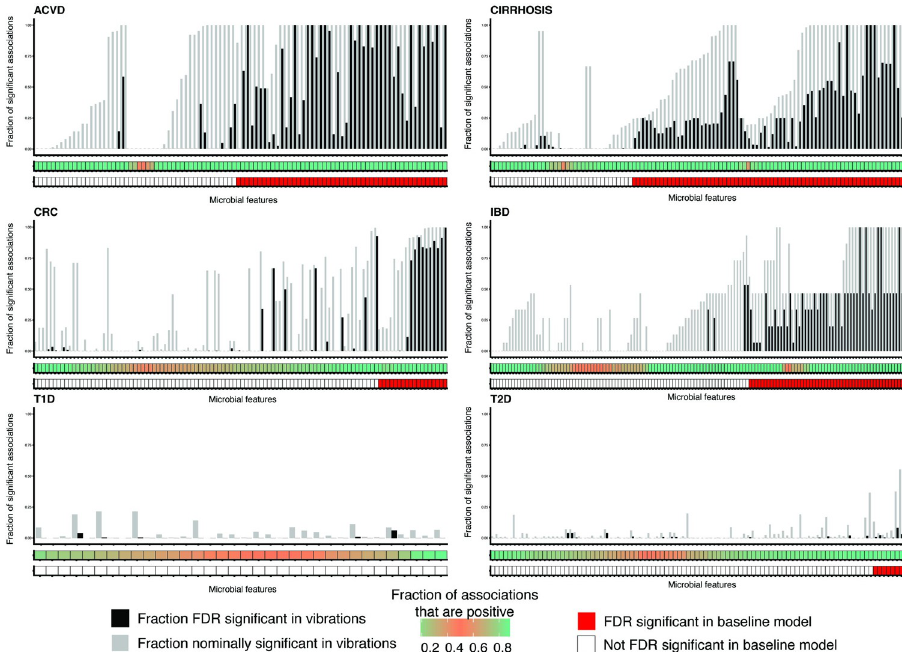
Fig 3. VoE for reported associations from the literature in the form of summarized modeling output. (A) We measure association robustness in part by computing the fraction of associations with signs greater than 0. These values show the distributions of these values for each microbial taxon). (B) Summarized modeling output. Red blocks indicate organisms that were FDR significant in our study. The middle bar describes the fraction of association sizes greater than 0 per taxon: a highly confounded association will be closer to 0.5 and pink, whereas more robust associations will be closer to 0 or 1 and green. The gray bars in the upper bar plot corresponds the fraction of models that were nominally ( p -value < 0.05) significant for the microbial feature–disease association, whereas the black bars correspond to the fraction of models that were FDR significant. Features marked as significant in our study but never FDR significant were only significant after the meta-analysis and did not have any nominal significant p -values. See S2 Fig for this plot reproduced with species names on the x-axis. This figure can be generated using the code deposited in https://github.com/chiragjp/ubiome_robustness and the data deposited in https://figshare.com/projects/Microbiome_ robustness/127607. ACVD, atherosclerotic cardiovascular disease; CRC, colorectal cancer; FDR, false discovery rate; IBD, inflammatory bowel disease; T1D, type 1 diabetes; T2D, type 2 diabetes; VoE, vibration of effects.